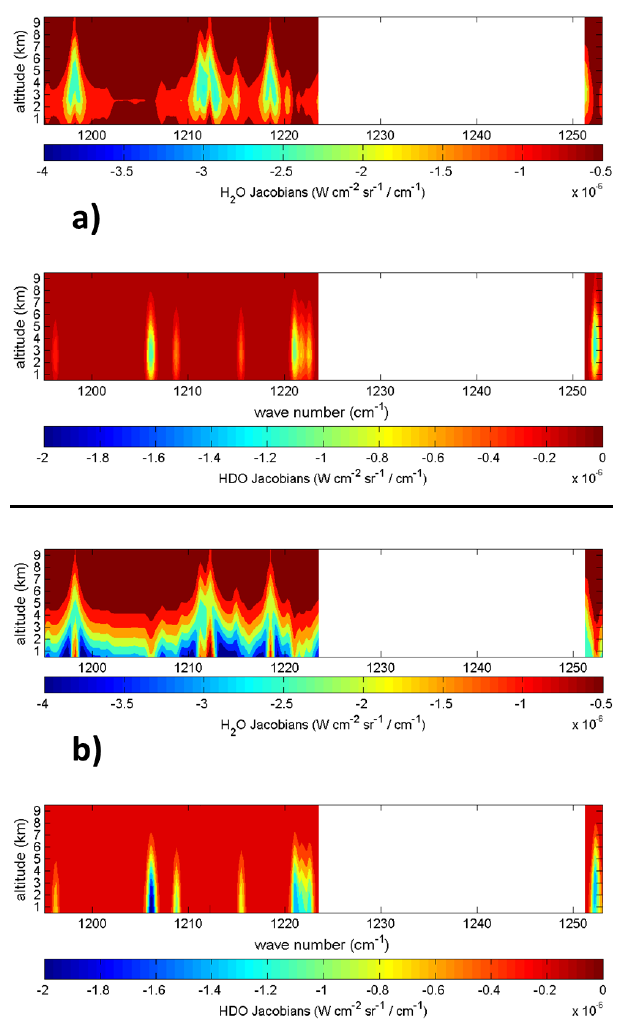
Figure 5. Mean AKs ( A ) with a | 1T | < 4K (a) and with a | 1T | > 8K (b) in 2011. See text for the definition of A hh , A dd , A hd and A dh and for the explanation of both panels. The coloured curves and dots aim to help the reader to follow the variability of each AK with